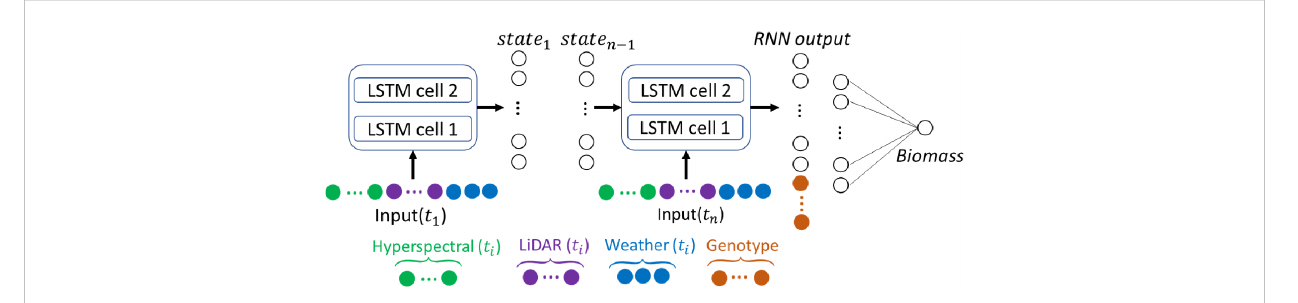
FIGURE 4 RNN-G biomass prediction model and input vectors including hyperspectral, LiDAR, and weather features at each stage, and the genotype